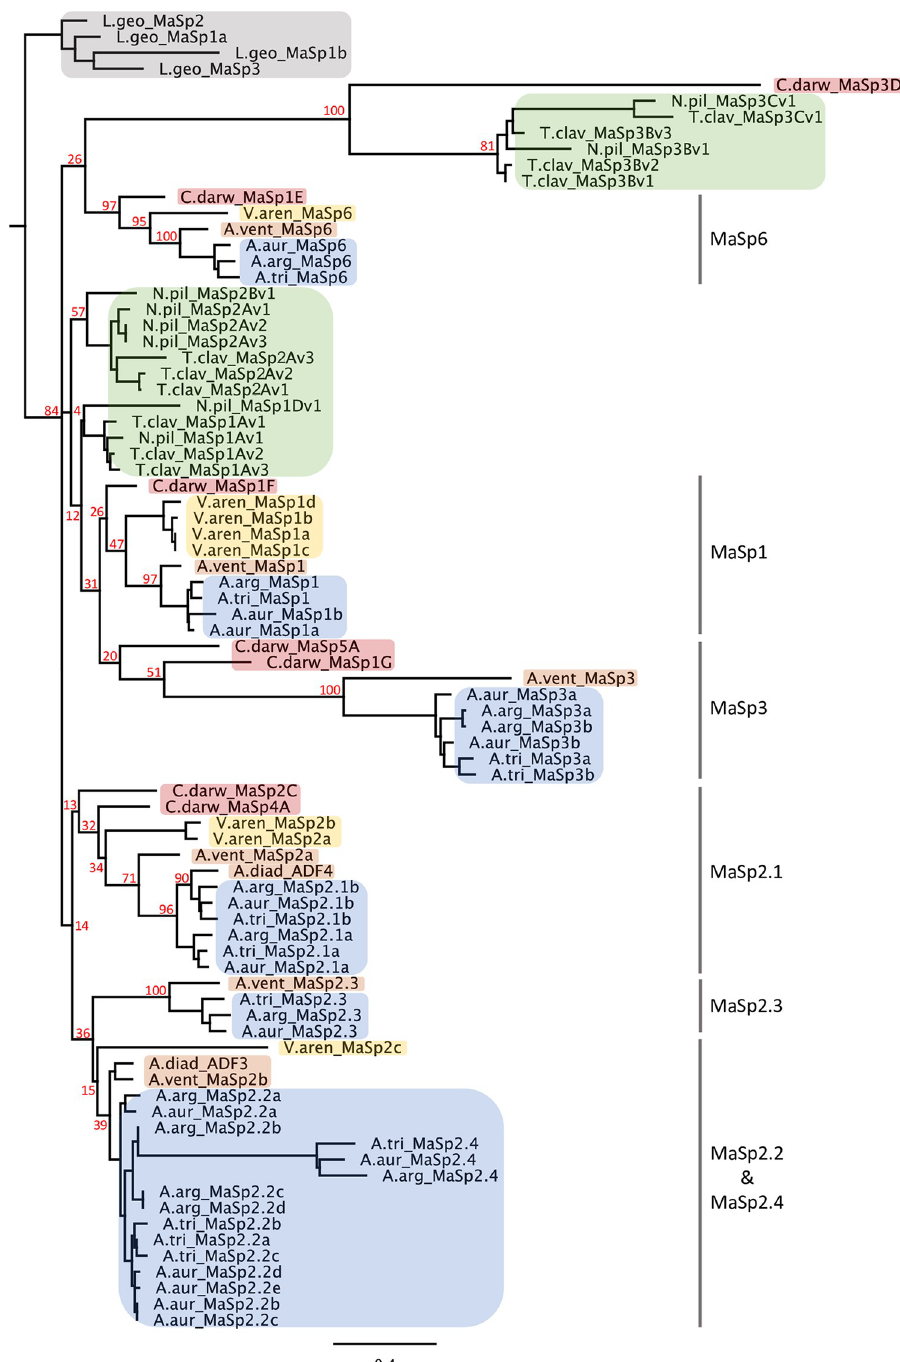
Fig 7. Phylogenetic relationship among MaSp genes within the Araneoidea. A ML tree of the concatenated protein sequences from the N- and C- terminal regions. Clade shading highlight different genera or families. A.diad– Araneus diadematus , A.vent– Araneus ventricosus , A.arg– Argiope argentata , A.aur– Argiope aurantia , A.tri– Argiope trifasciata , C.darw– Caerostris darwini , L.geo– Latrodectus geometricus , N.pil– Nephila pilipes , T.clav– Trichonephila clavipes , V. aren– Verrucosa arenata . Bootstrap values provided for most nodes. See S16 Fig for similar ML tree of Araneidae taxa based on N- plus C-termini DNA sequences.